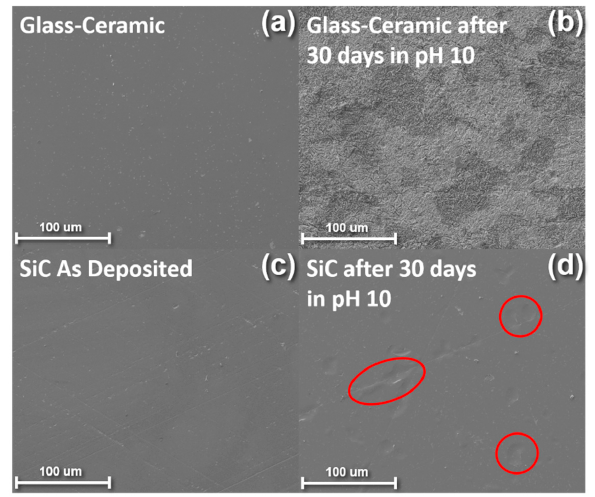
Figure 1. SEM images of ( a ) a fluorapatite glass-ceramic disk before corrosion ( b ) a fluorapatite glass- ceramic disk after corrosion ( c ) a SiC-coated fluorapatite glass-ceramic disk before corrosion and ( d ) a SiC-coated fluorapatite glass-ceramic disk after corrosion.